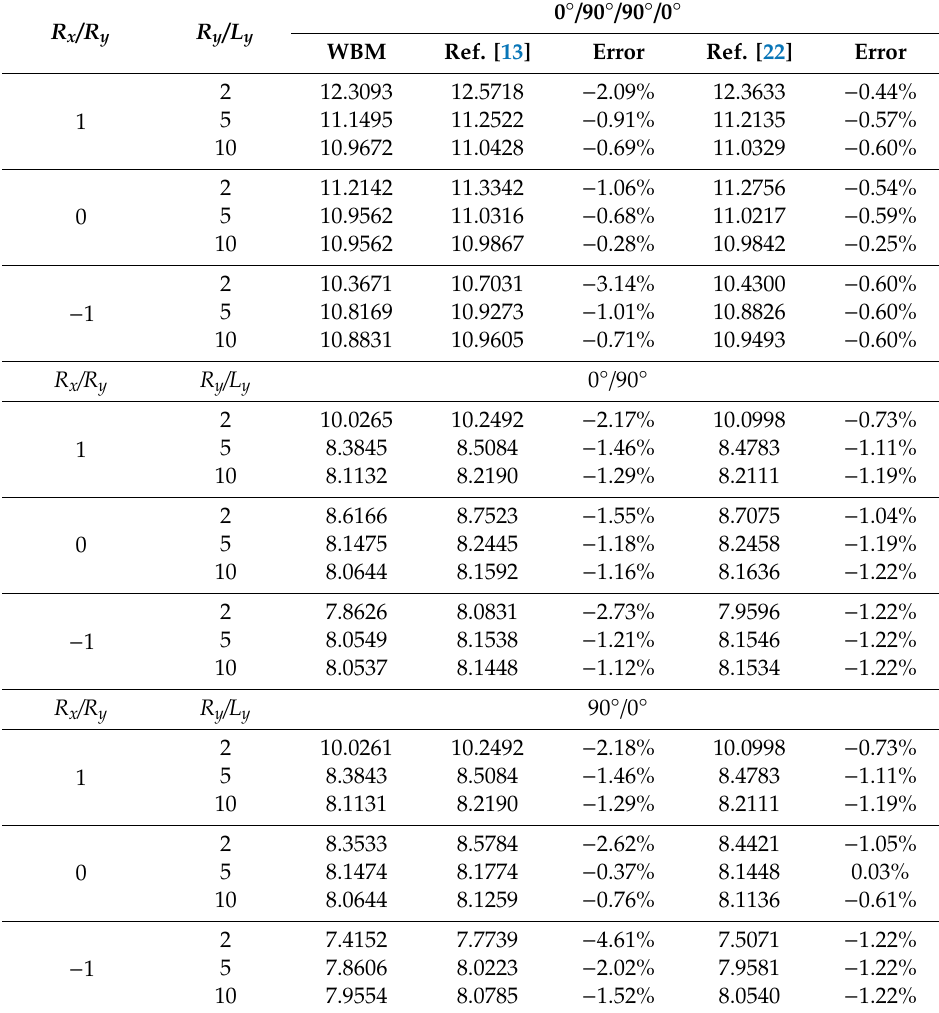
Table 1. The fundamental frequency parameter Ω for the composite shallow shell with the SD-SD boundary condition by first-order shear deformation shell theory (FSDT). WBM, wave-based